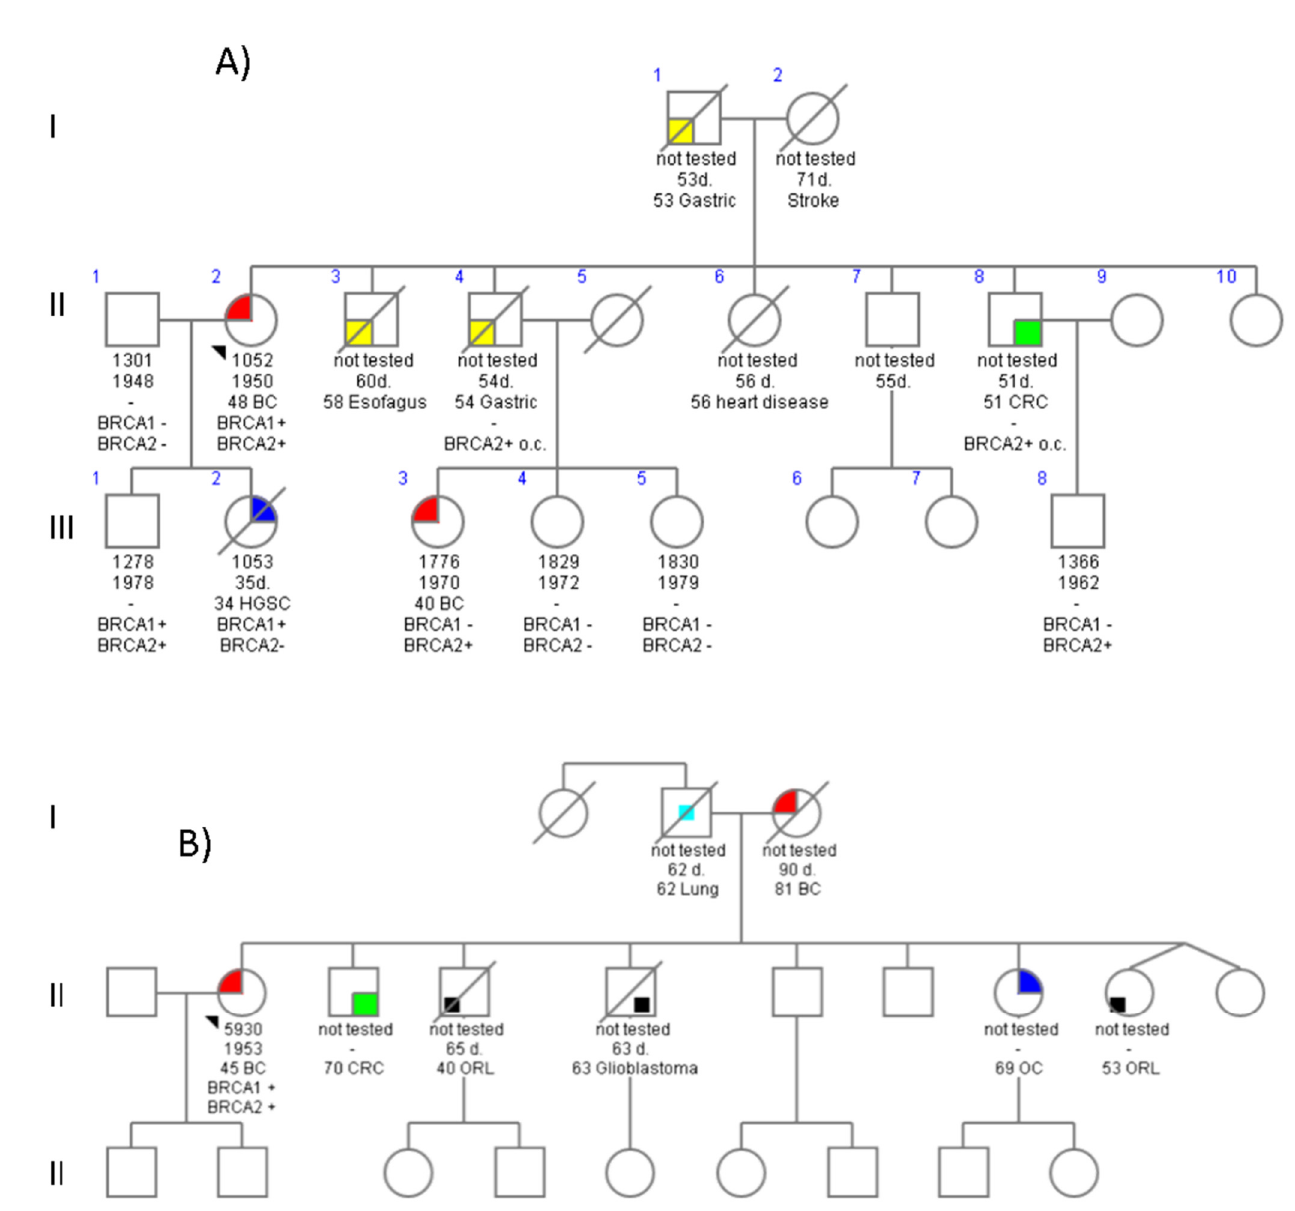
Figure 1. Pedigrees of double heterozygote BRCA1/BRCA2 families. ( A ) Family with c.34C>T (p.Gln13*) in BRCA1 and c.1587delTinsCA (p.Glu532Argfs*3) in BRCA2. ; ( B ) Family with c.- 232_*1383{0} (p.Met1ValfsX13) in BRCA1 and c.5796_5797delTA (p.His1932Glnfs*12) in BRCA2. ; Index cases are indicated by an arrow. Confirmed mutation carriers are indicated by a “+” sign, and non-carriers are indicated by a “-” sign; o.c., obligate carriers. Age at diagnosis and cancer type is specified as follows: BC, breast cancer; OC, ovarian cancer; HGSC, high-grade serous-papillary ovarian carcinoma; CRC, colorectal cancer; ORL, oral cancer. The colors stand for each type of cancer as follows: red stands for BC, blue stands for OC, green stands for CRC, yellow stands for Gastric Cancer, black stands for another type of